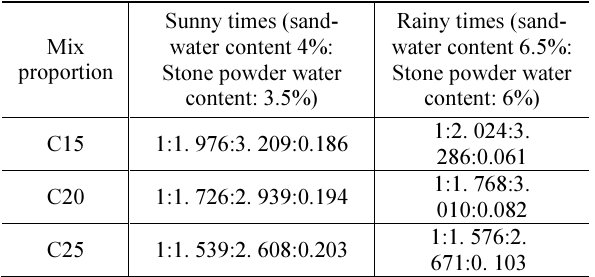
Table 4. The best mix